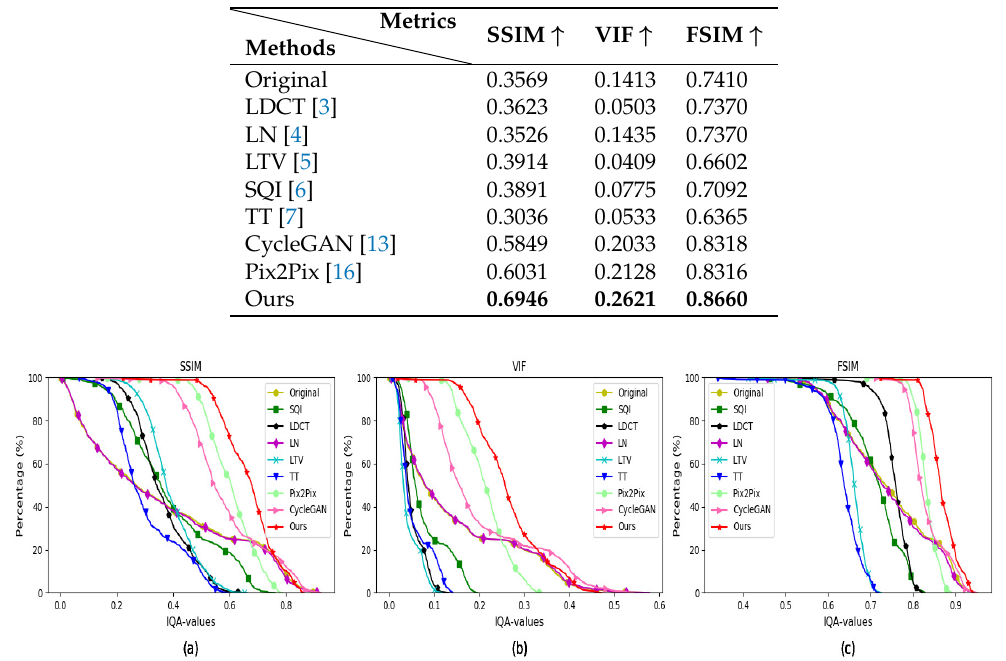
Table 3. Average FR-IQA values of the face images synthesized by various illumination-processing methods on the YaleB dataset.